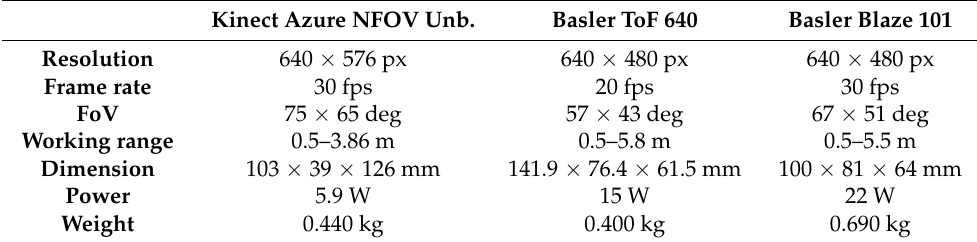
Table 1. Summary of cameras’ depth mode technical